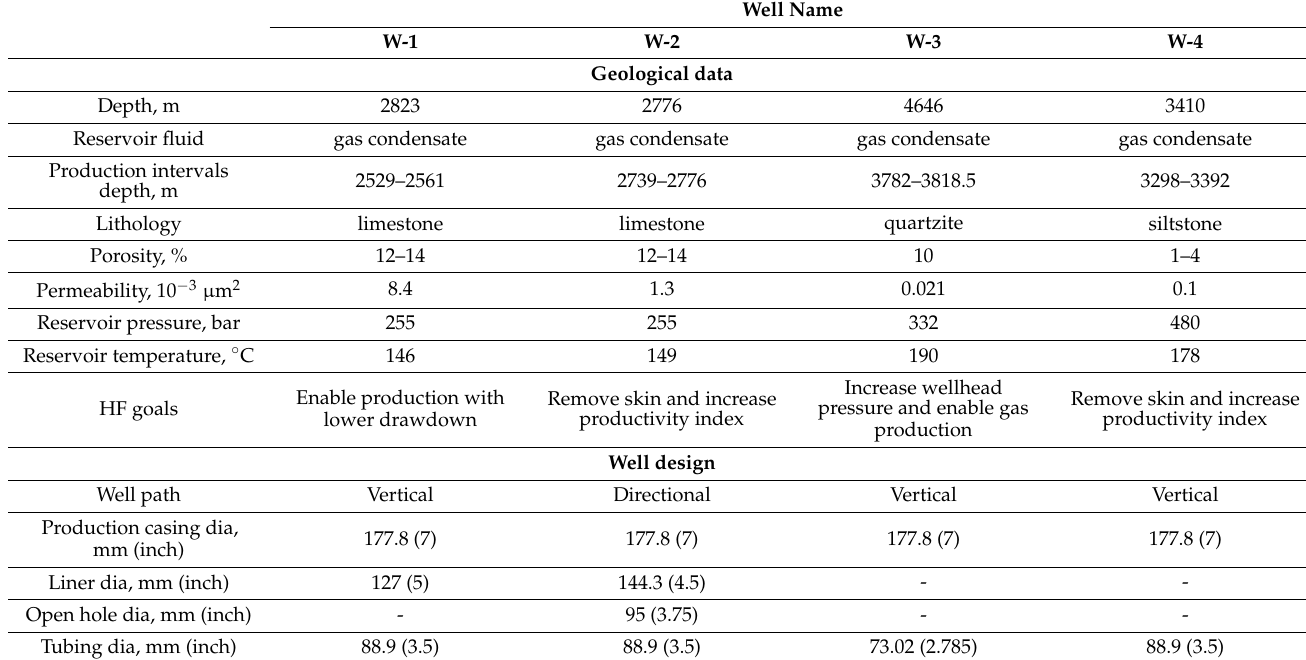
Table 14. Geological and well design data for the selected wells. W-1–W-4: well 1–well 4. Well Name W-1